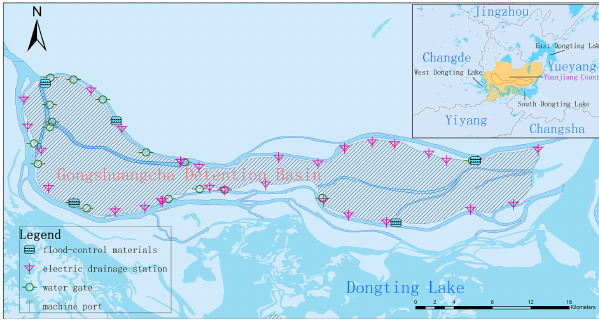
Figure 2. The location of the Gongshuangcha detention basin in the Dongting Lake